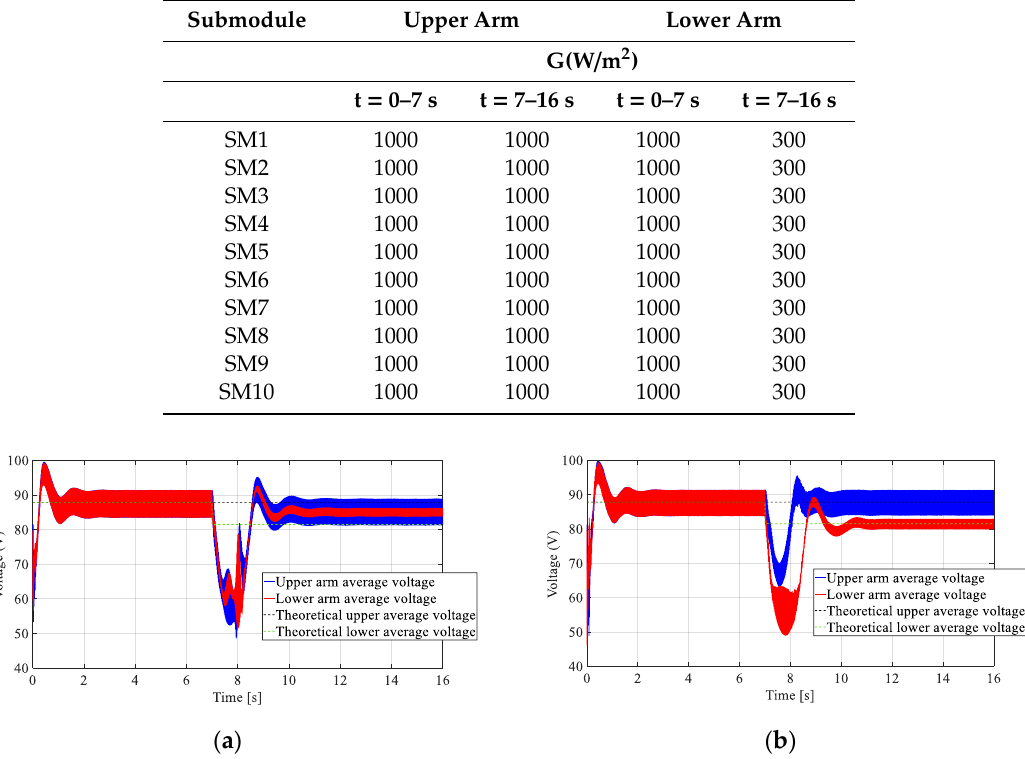
Table 3. Scenario 1. Different partial shading conditions in one arm.